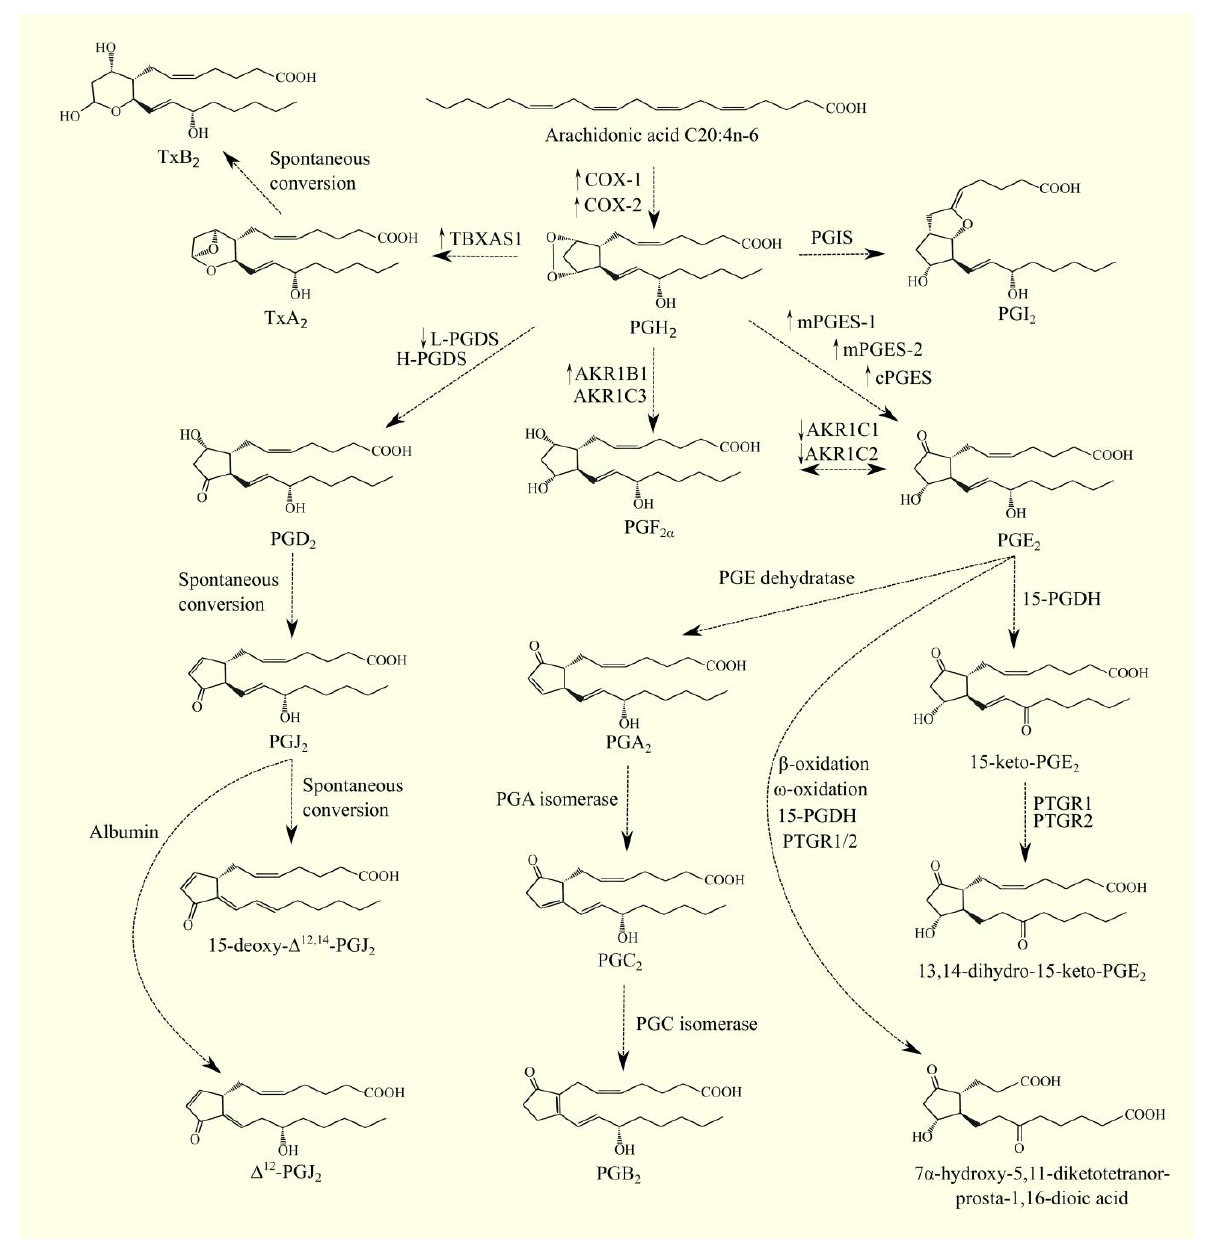
Figure 3. COX pathway. After release by PLA 2 , ARA C20:4n-6 is converted into prostanoids with COX. It is transformed into PGH 2 with either COX-1 or COX-2. Then, this prostaglandin is transformed into other prostaglandins (PGE 2 , PGD 2 , PGI 2 , and PGF 2α ) or TxA 2 by the respective synthases. These lipid mediators undergo further transformations. TxA 2 is unstable and undergoes a spontaneous transformation into TxB 2 . Similarly, PGD 2 undergoes spontaneous transformation to PGJ 2 — this prostaglandin can then be transformed into 15-deoxy- Δ 12,14 -PGJ 2 (15d-PGJ 2 ) or Δ 12 -PGJ 2 . PGE 2 can be transformed into PGA 2 , and then into PGC 2 and PGB 2 . Prostanoids also undergo degradation. The figure shows an example of PGE 2 , which undergoes inactivation by oxidation with 15-PGDH and reduction with PTGR1/2. PGE 2 can also undergo degradation by β -oxidation and ω -oxidation, followed by the action of 15-PGDH and PTGR1/2. The resulting degradation product is PGE 2 , which is removed from the body. ↑— higher expression of given enzymes in GBM tumor relative to healthy tissue; ↓ — lower expression of given enzymes in GBM tumor relative to healthy tissue.